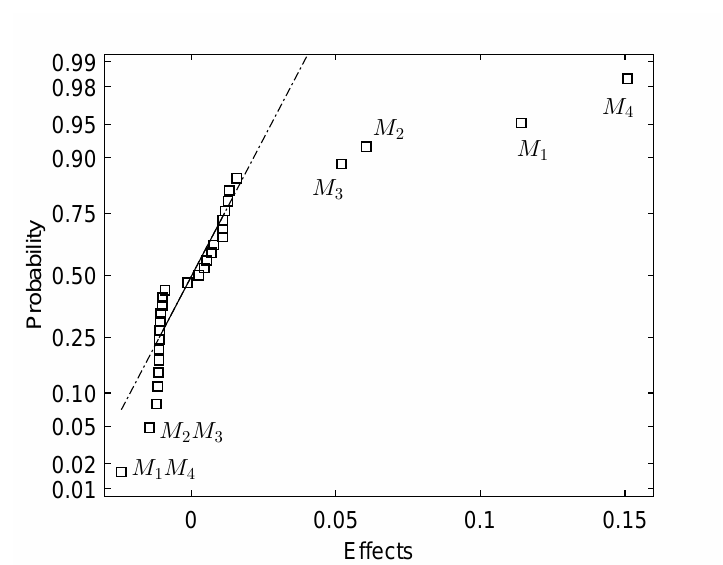
Figure 9. Normal probability plots for stage I showing effects on pressure ratio.